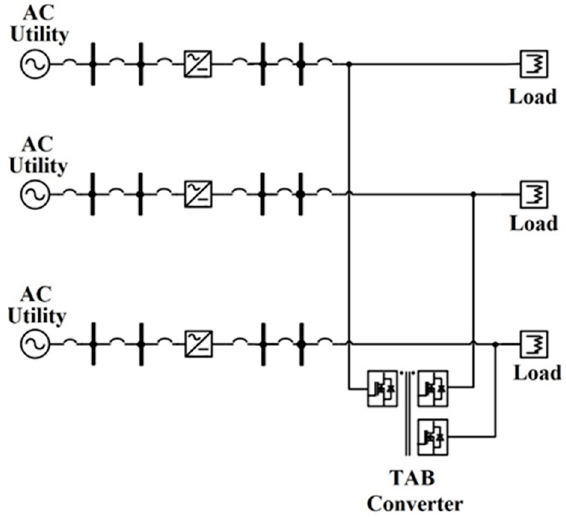
Figure 11. Reliability model of the proposed DC power distribution system. Table 3. Reliability parameters of electrical components used in industrial and commercial systems [30,31]. MTBF: mean time between failures.